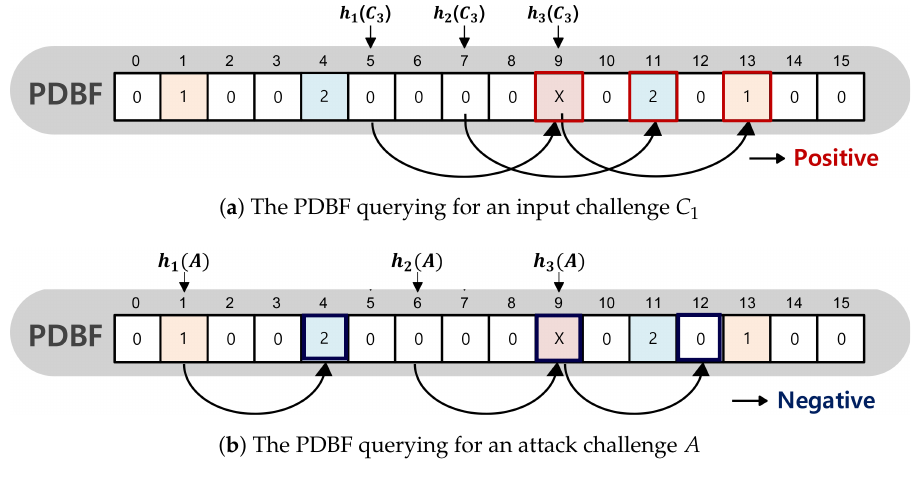
Figure 3. Querying procedure for a PDBF.